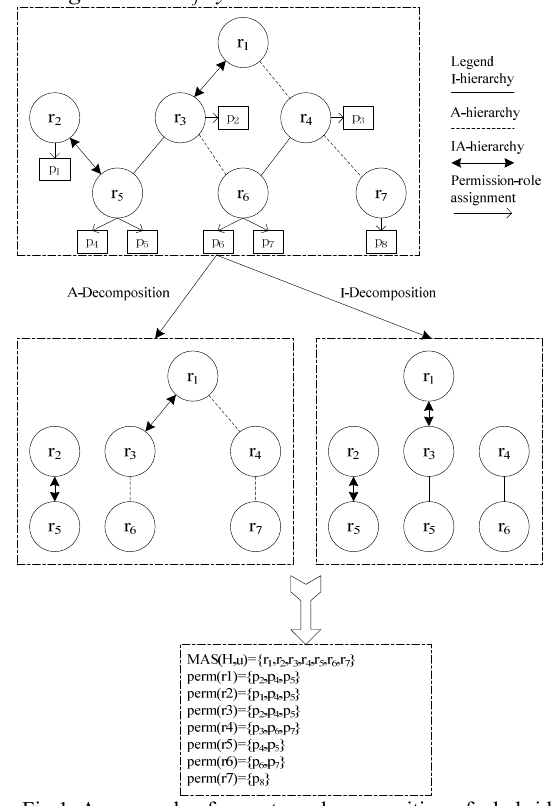
Fig.1. An example of monotype decomposition of a hybrid